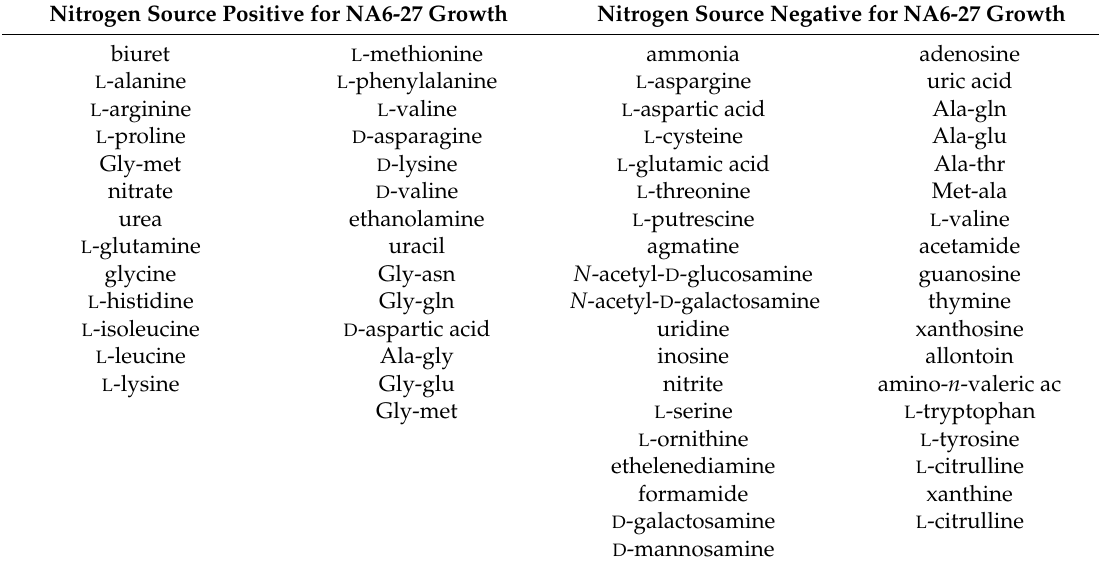
Table 1. Biolog assays. Nitrogen source utilization by Great Salt Lake (GSL) strain, NA6-27. Sources that resulted in observed growth are indicated as positive and are shown in the first two columns. Negative results are shown in the third and fourth columns.